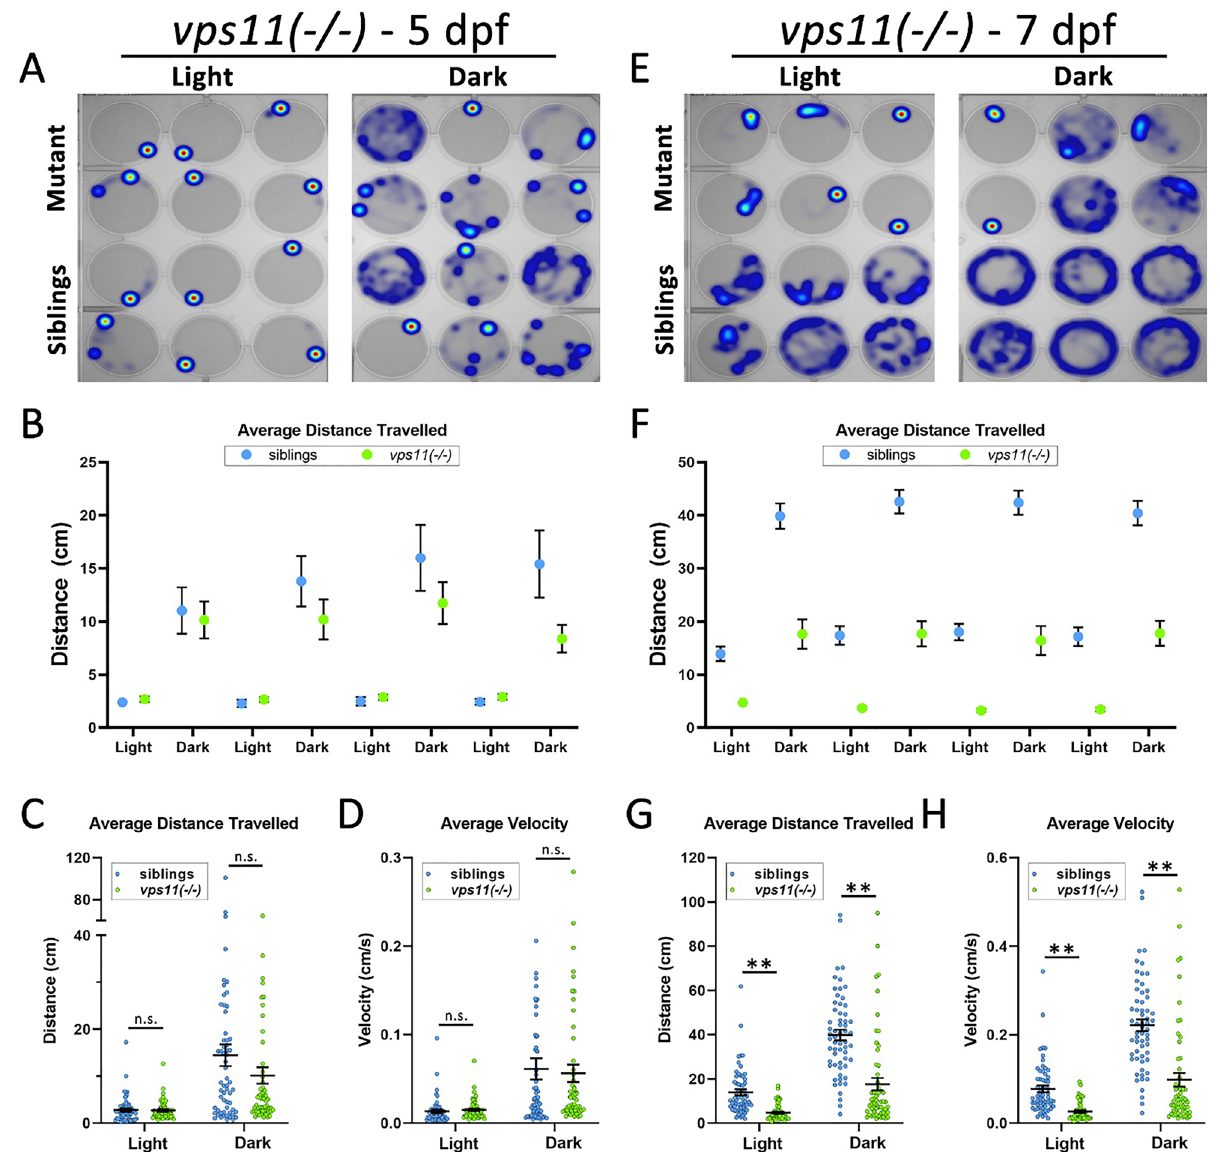
Figure 3. vps11 (−/−) mutants show normal distance travelled and velocity at 5dpf and significantly reduced distance travelled and velocity at 7dpf during alternating cycles of light and dark. ( A ) Representative heat maps of total distance moved by individual vps11 (−/−) larvae at 5dpf (mutants = top two rows; siblings = bottom two rows) during a 3-min period of light and dark. ( B ) Graph representing average distance travelled in 4 alternating light–dark cycles of 3 min each (sibling larvae in blue; mutants in green). ( C ) Graph representing average distance travelled in light and dark periods. ( D ) Graph representing average velocity of sibling and vps11 (−/−) larvae in light and dark periods. n = 60 siblings and 58 vps11 (−/−) larvae. ( E ) Representative heat maps generated of total distance moved by individual vps11 (−/−) larvae at 7dpf (mutants = top two rows; siblings = bottom two rows) in a 3-min period of light and dark. ( F ) Graph representing average distance travelled in 4 alternating light–dark cycles of 3 min each (sibling larvae in blue; vps11 (−/−) mutants in green). ( G ) Graph representing average distance travelled in light and dark periods. ( H ) Graph representing average velocity of sibling and vps11 (−/−) larvae in light and dark periods. n = 60 siblings and 57 vps11 (−/−) larvae. ** P < 0.01. Error bars indicate